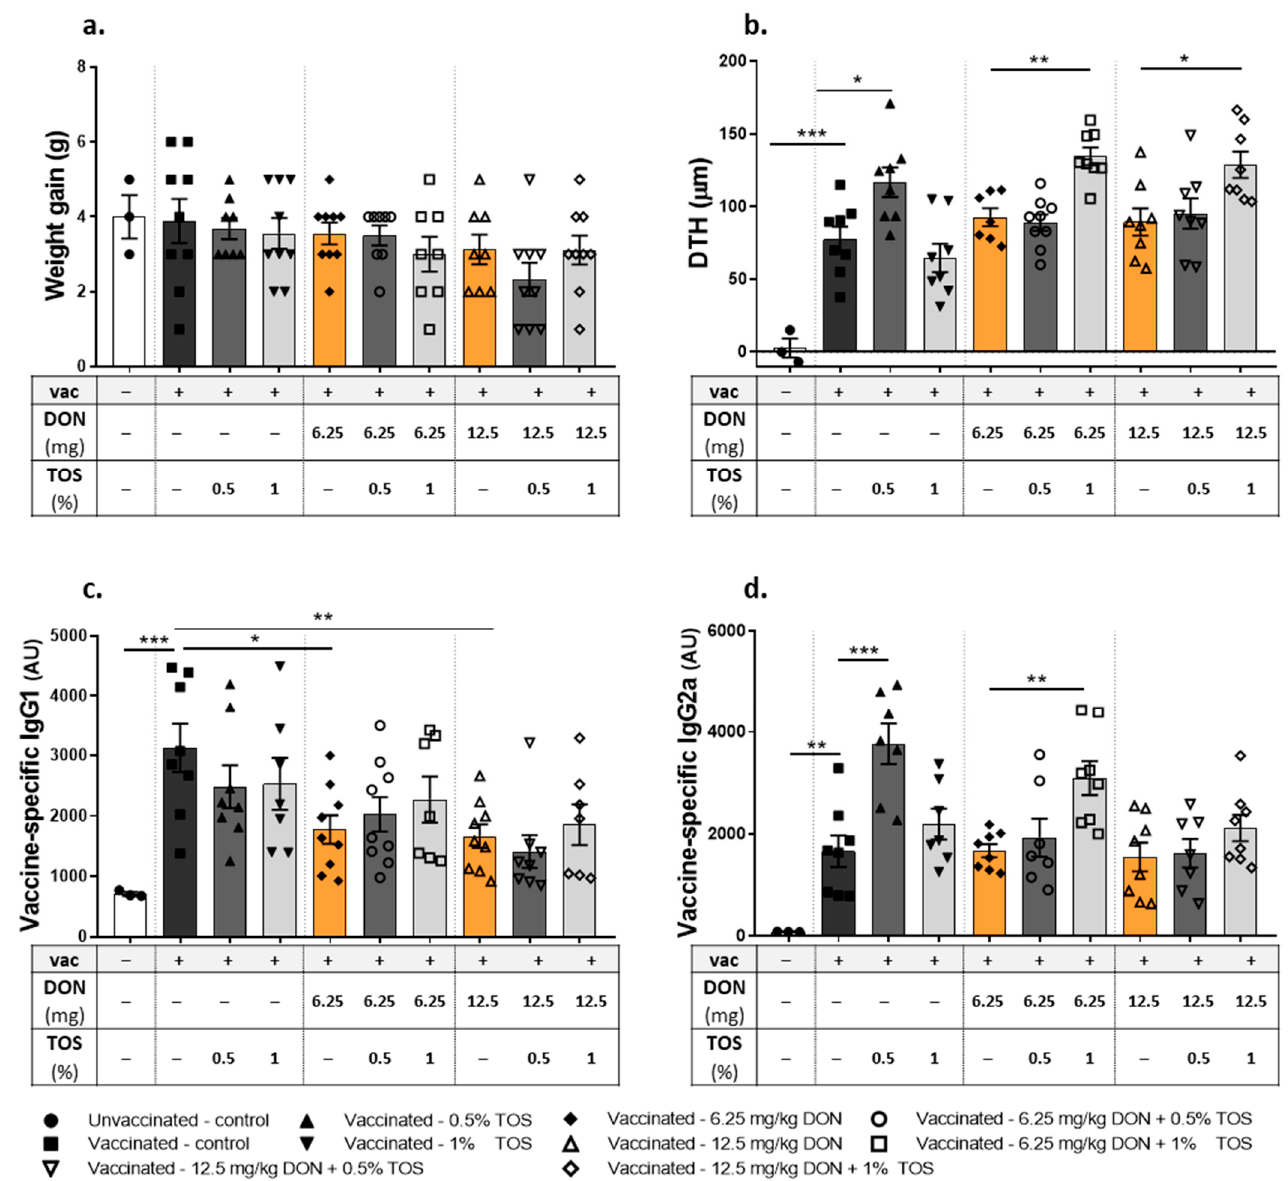
Figure 2. Effect of dietary intervention with deoxynivalenol (DON) and trans-galacto-oligosaccharides (TOS) on weight gain, vaccine-specific delayed-type hypersensitivity (DTH) responses and antibody levels in serum collected on day 31 from vaccinated (vac +) and unvaccinated (vac − ) mice. ( a ) Weight gain throughout the experiment; ( b ) DTH response; ( c ) vaccine-specific IgG1; and ( d ) IgG2a levels in serum, measured by means of ELISA assays. Data are presented as mean ± SEM. * p < 0.05, ** p < 0.01 and *** p < 0.001 indicate statistical differences.